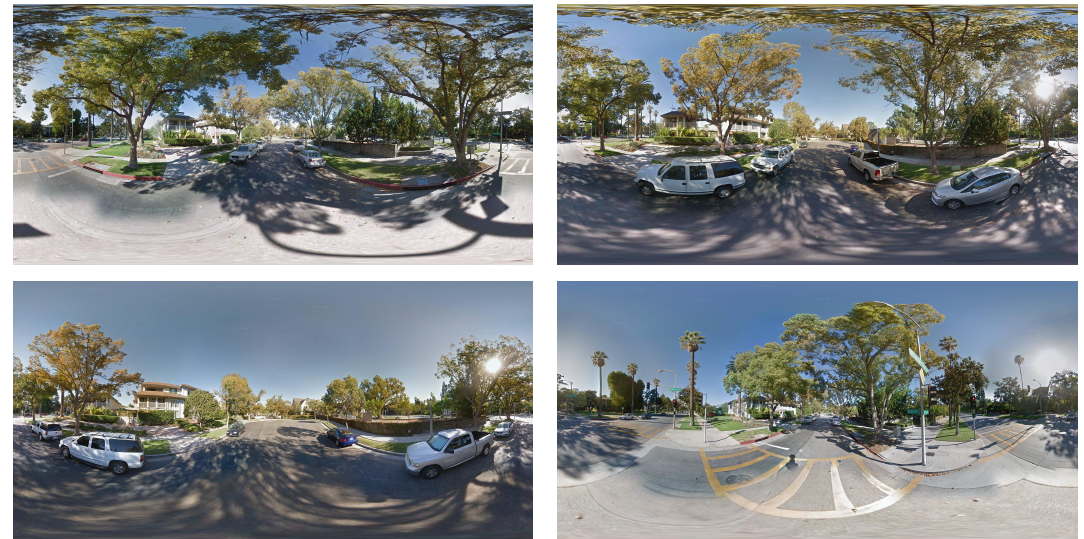
Figure 5. Four consecutive panoramas from the Pasadena dataset (Imagery c (cid:13) 2019 Google).